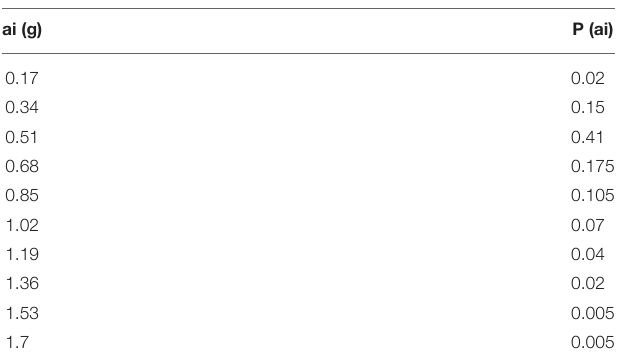
TABLE 4 | Scenario seismic ground accelerations and occurrence probabilities for Acapulco.